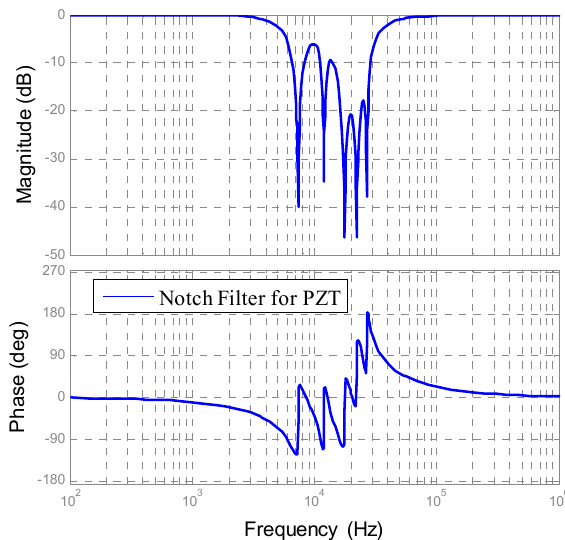
Figure 12. The frequency response of the complicated PZT model and complicated the PZT model with a notch filter .